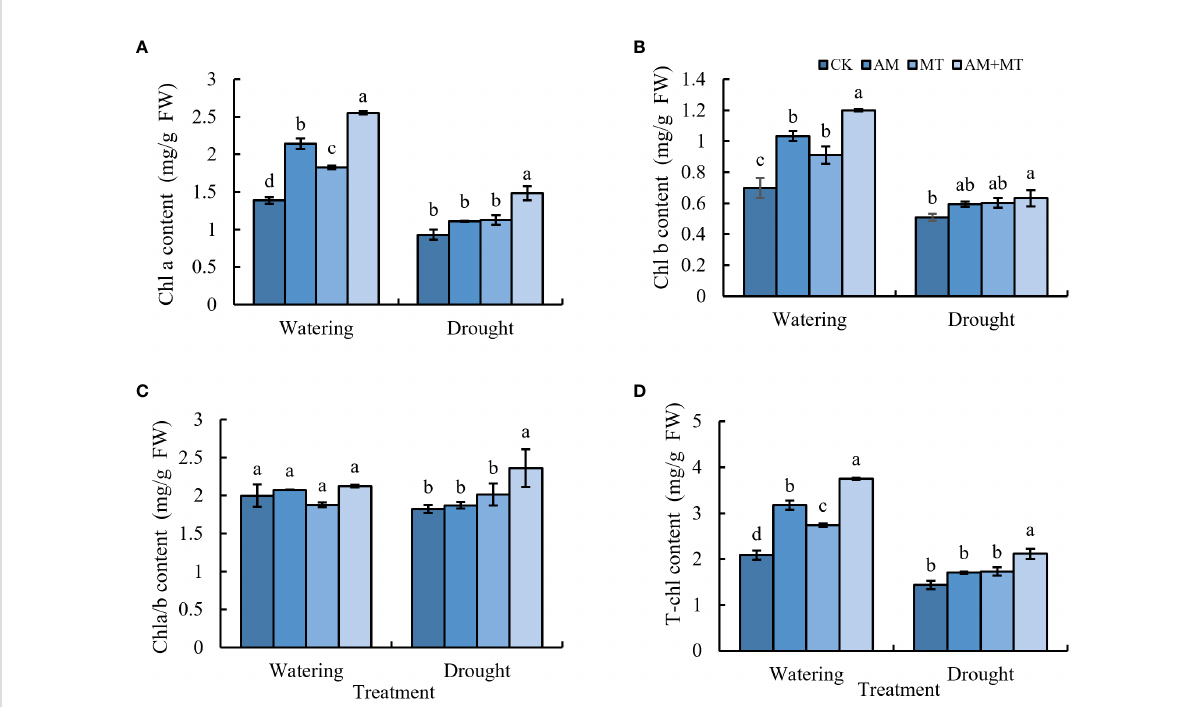
FIGURE 4 The content of chlorophyll a (A) , chlorophyll b (B) , total chlorophyll (C) , and chlorophyll a/b (D) in kiwifruit seedlings under well-watering or drought condition. Data are presented as meant ± SD ( n = 6), different letters indicate signi fi cant differences between treatments at p < 0.05 by Tukey ’ s Post Hoc test. Treatments included CK (the control), AM (inoculated with arbuscular mycorrhiza), MT (irrigated with 100 m M melatonin), and AM+MT (treated with melatonin and arbuscular